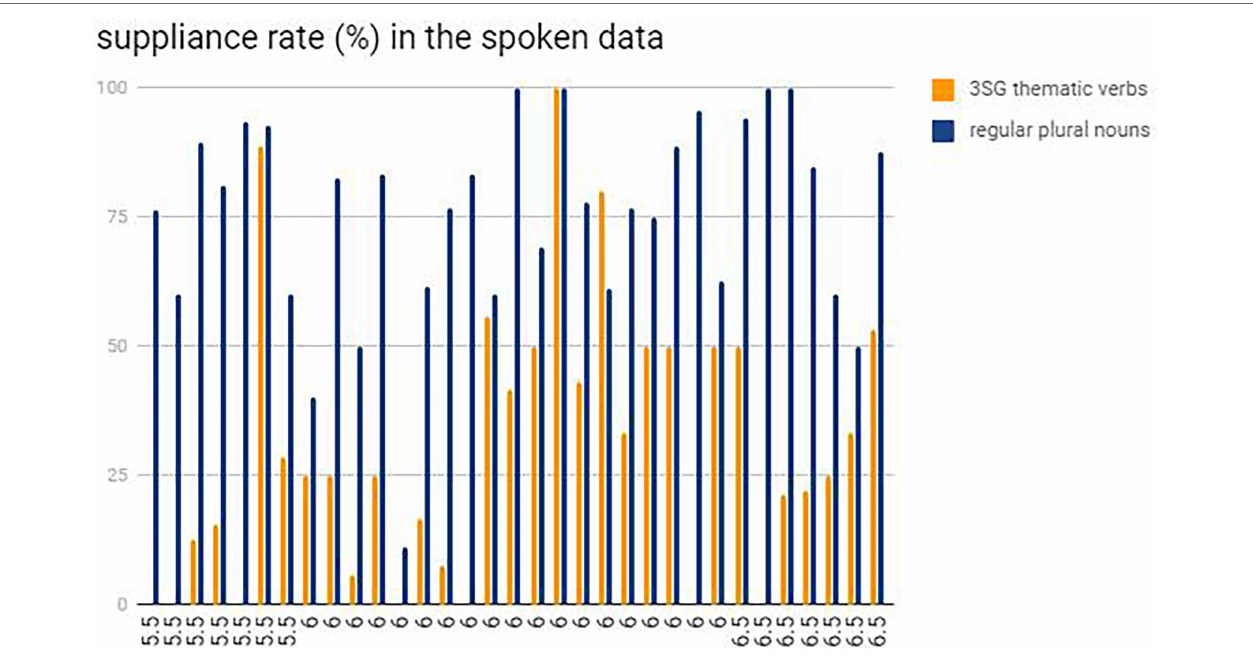
FIGURE 4 | The comparison of suppliance rates between 3SG ‘ -s ’ and plural ‘ -s ’: individual results in the spoken data.